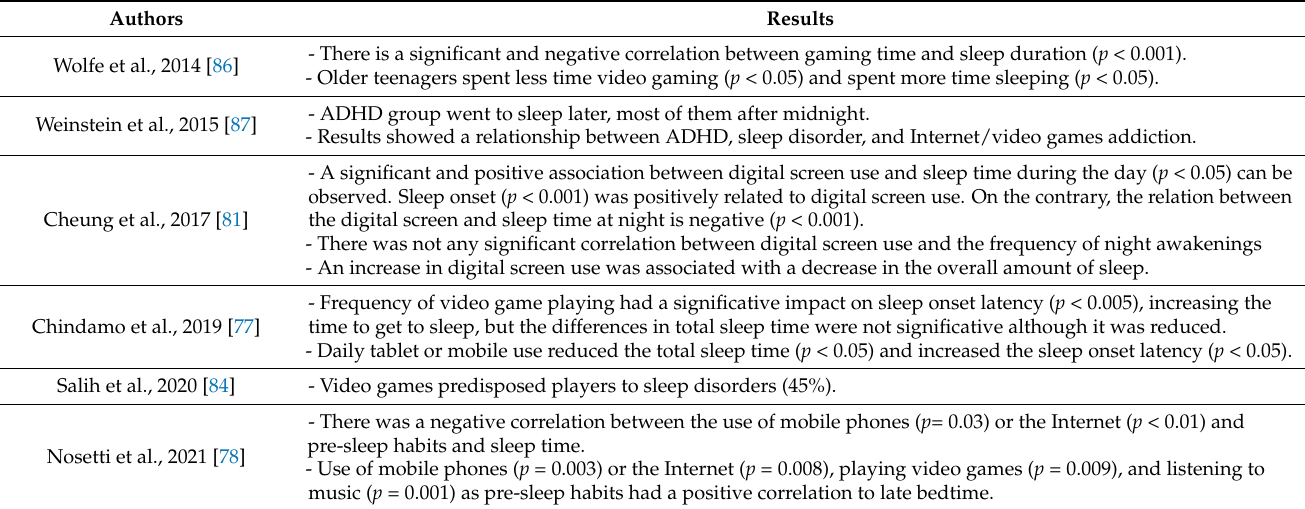
Table 3. Results related to sleep disorders.